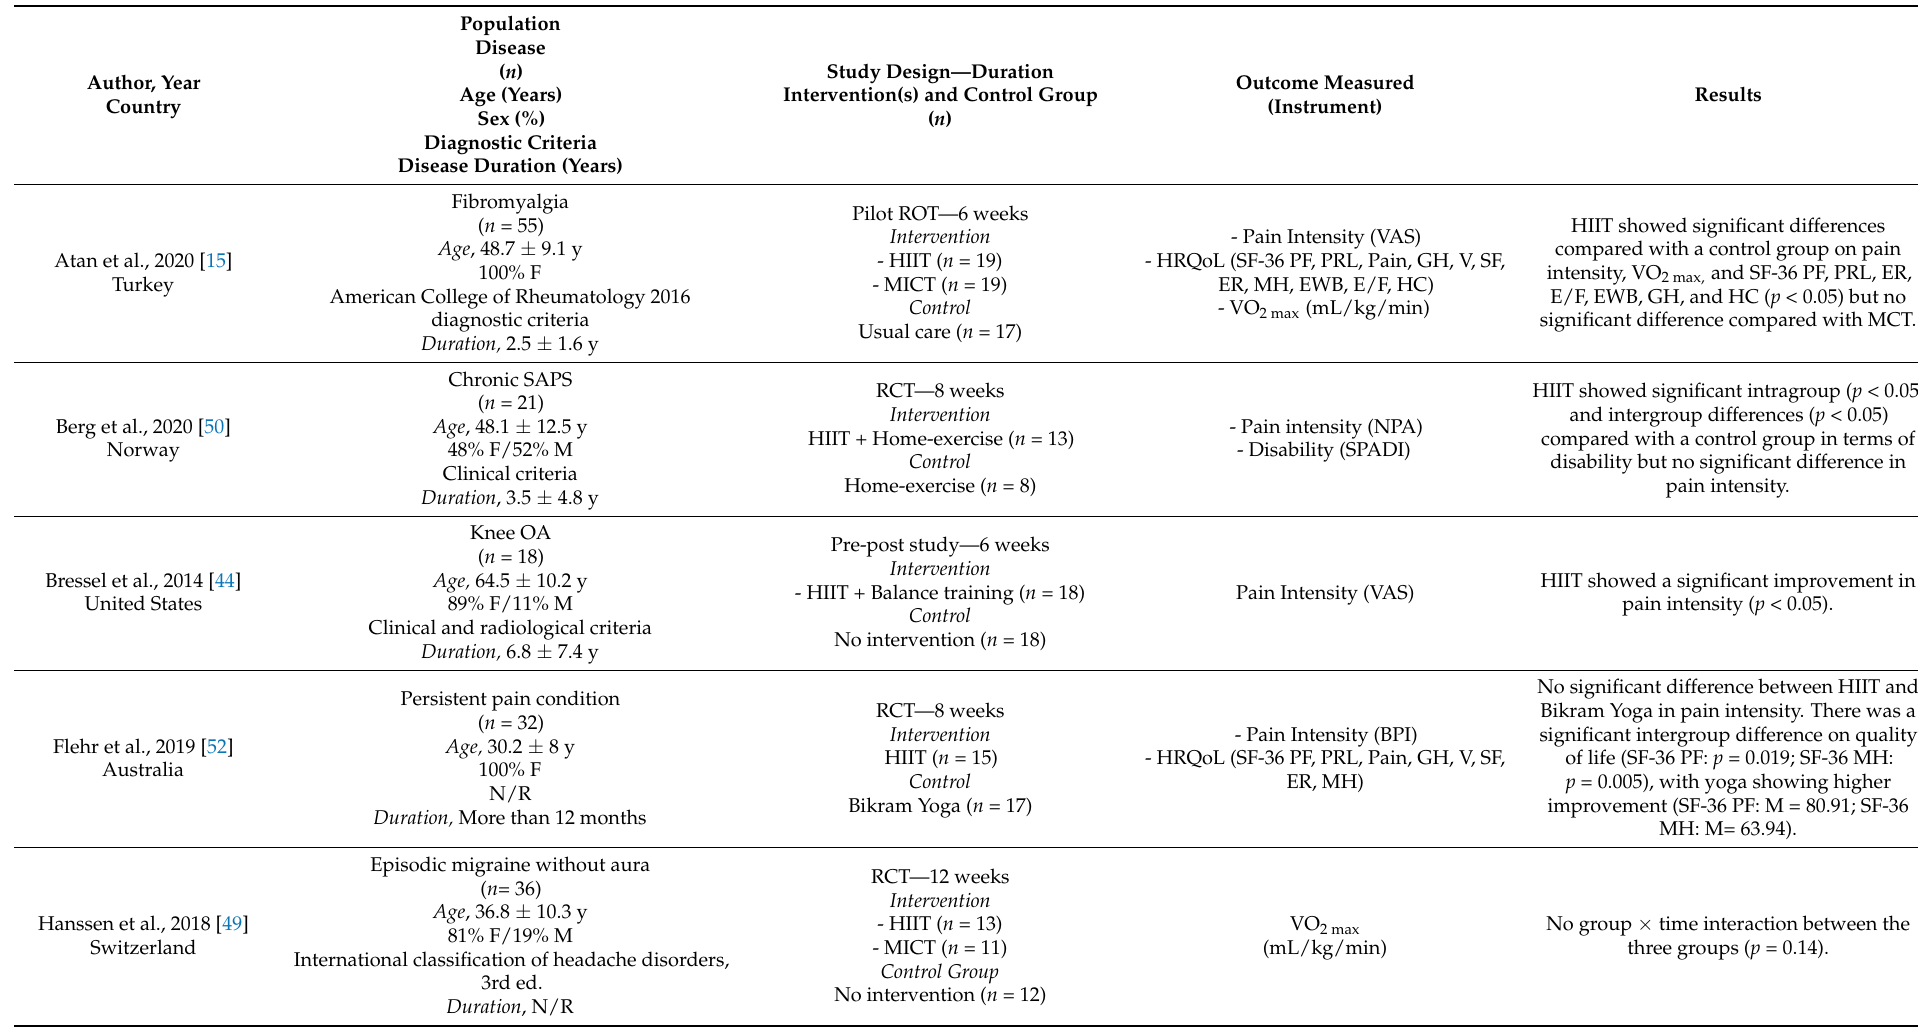
Table 1. Characteristics of the included